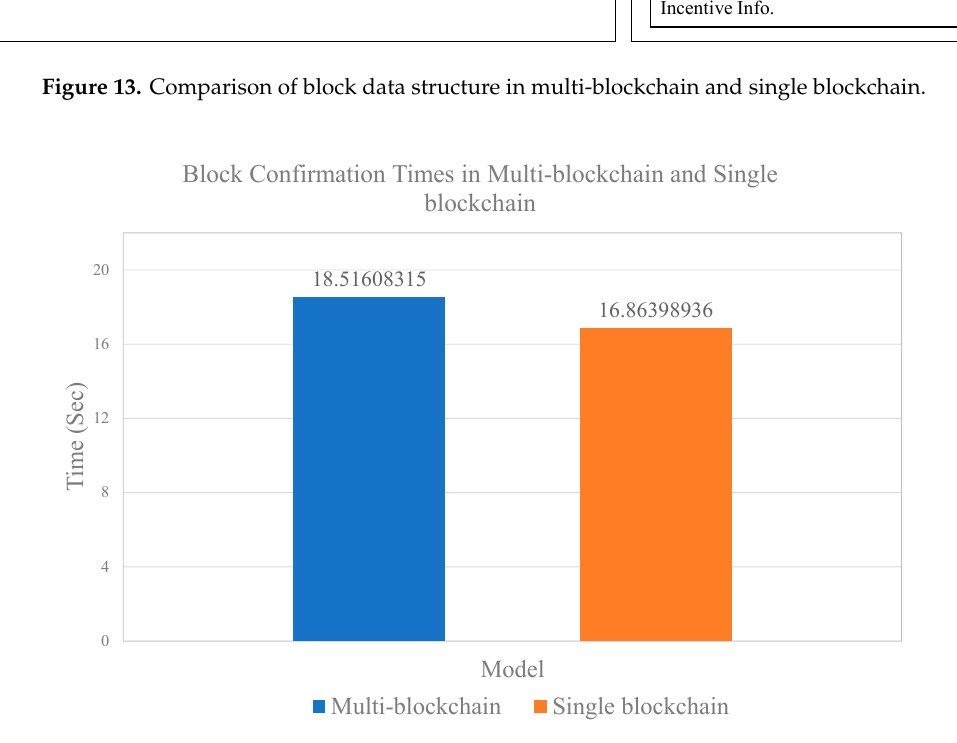
Figure 14. Comparison of transaction confirmation time in multi-blockchain and single blockchain.